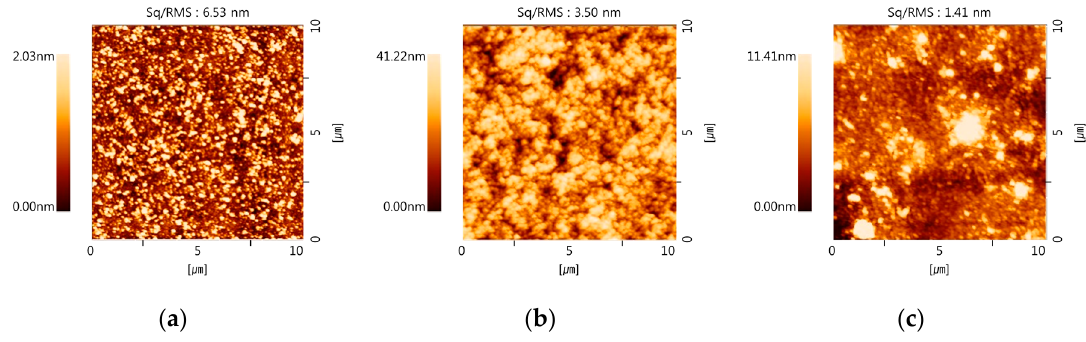
Figure 3. AFM images of functional coating film according to the annealing condition, ( a ) is naturally dried, ( b ) is annealed with H 2, and ( c ) is annealed in a vacuum.